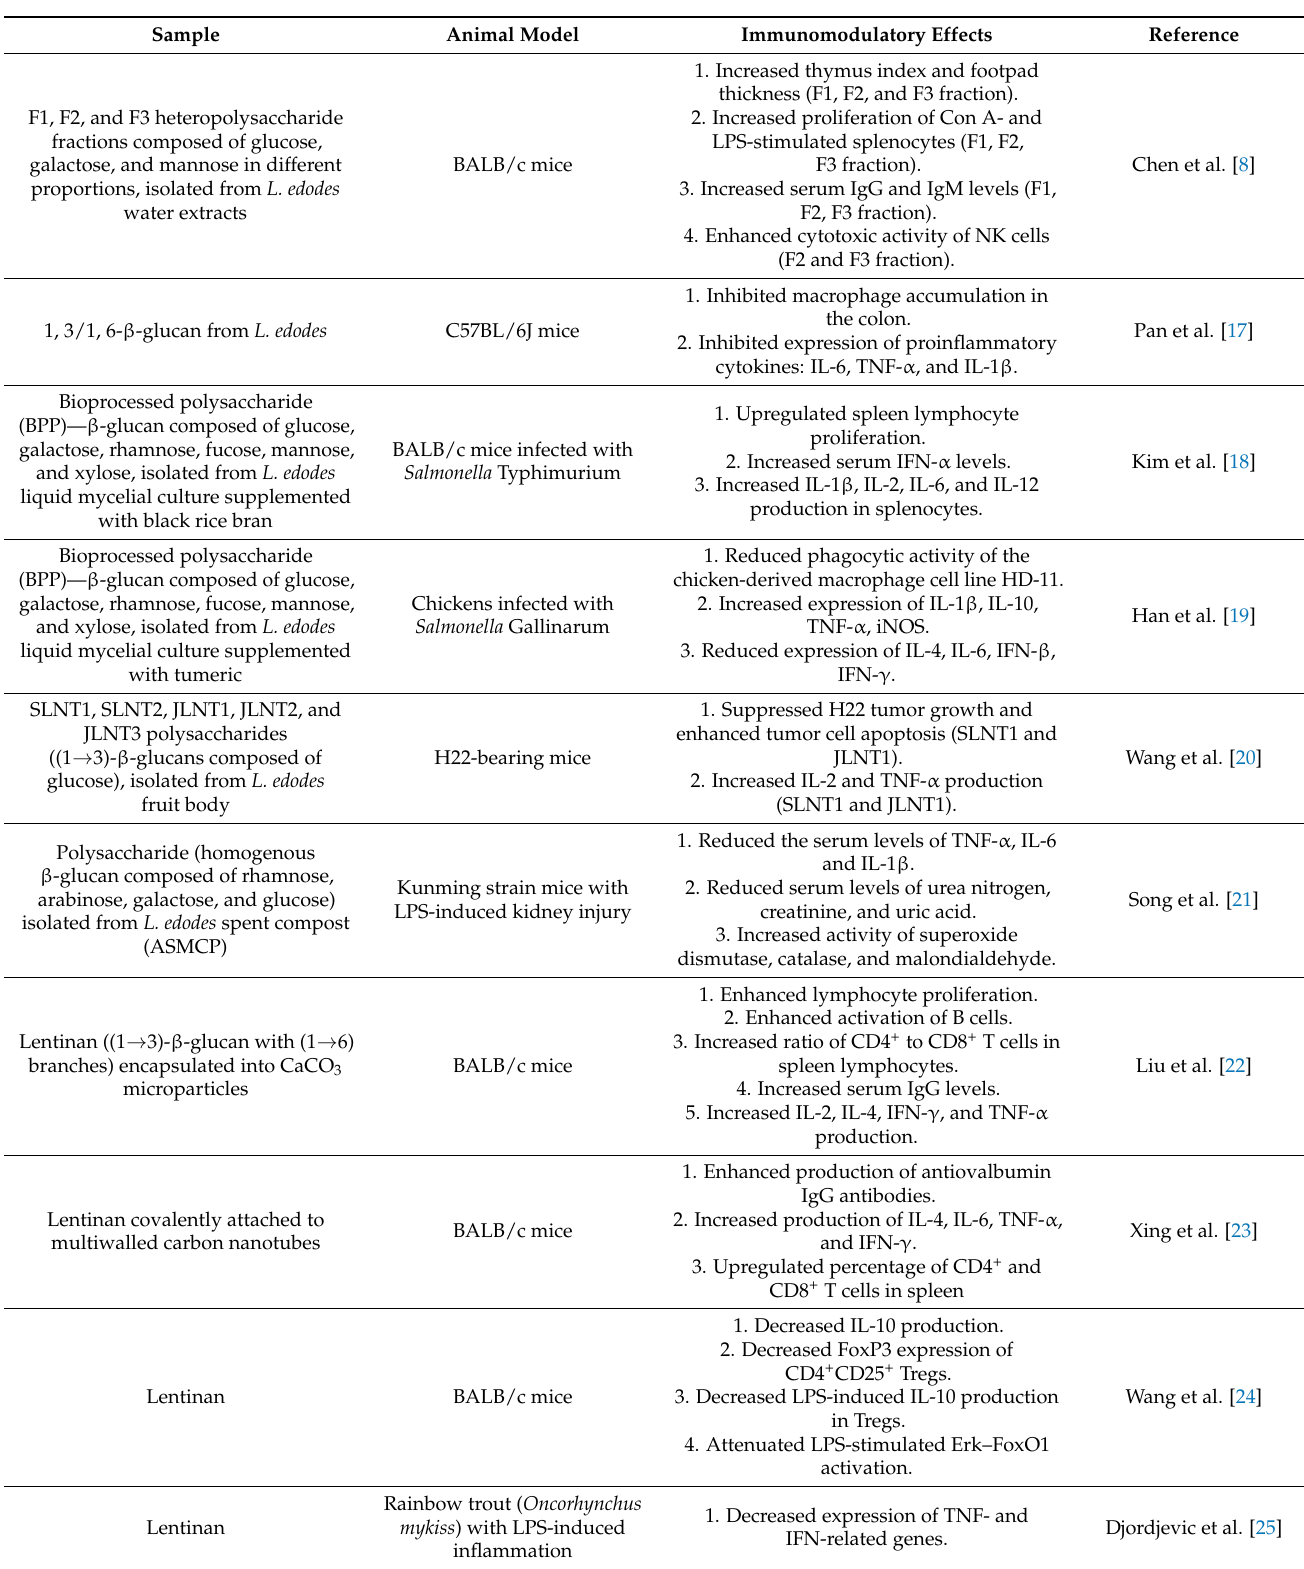
Table 1. Main studies of immunomodulatory effects of L. edodes polysaccharides in animal